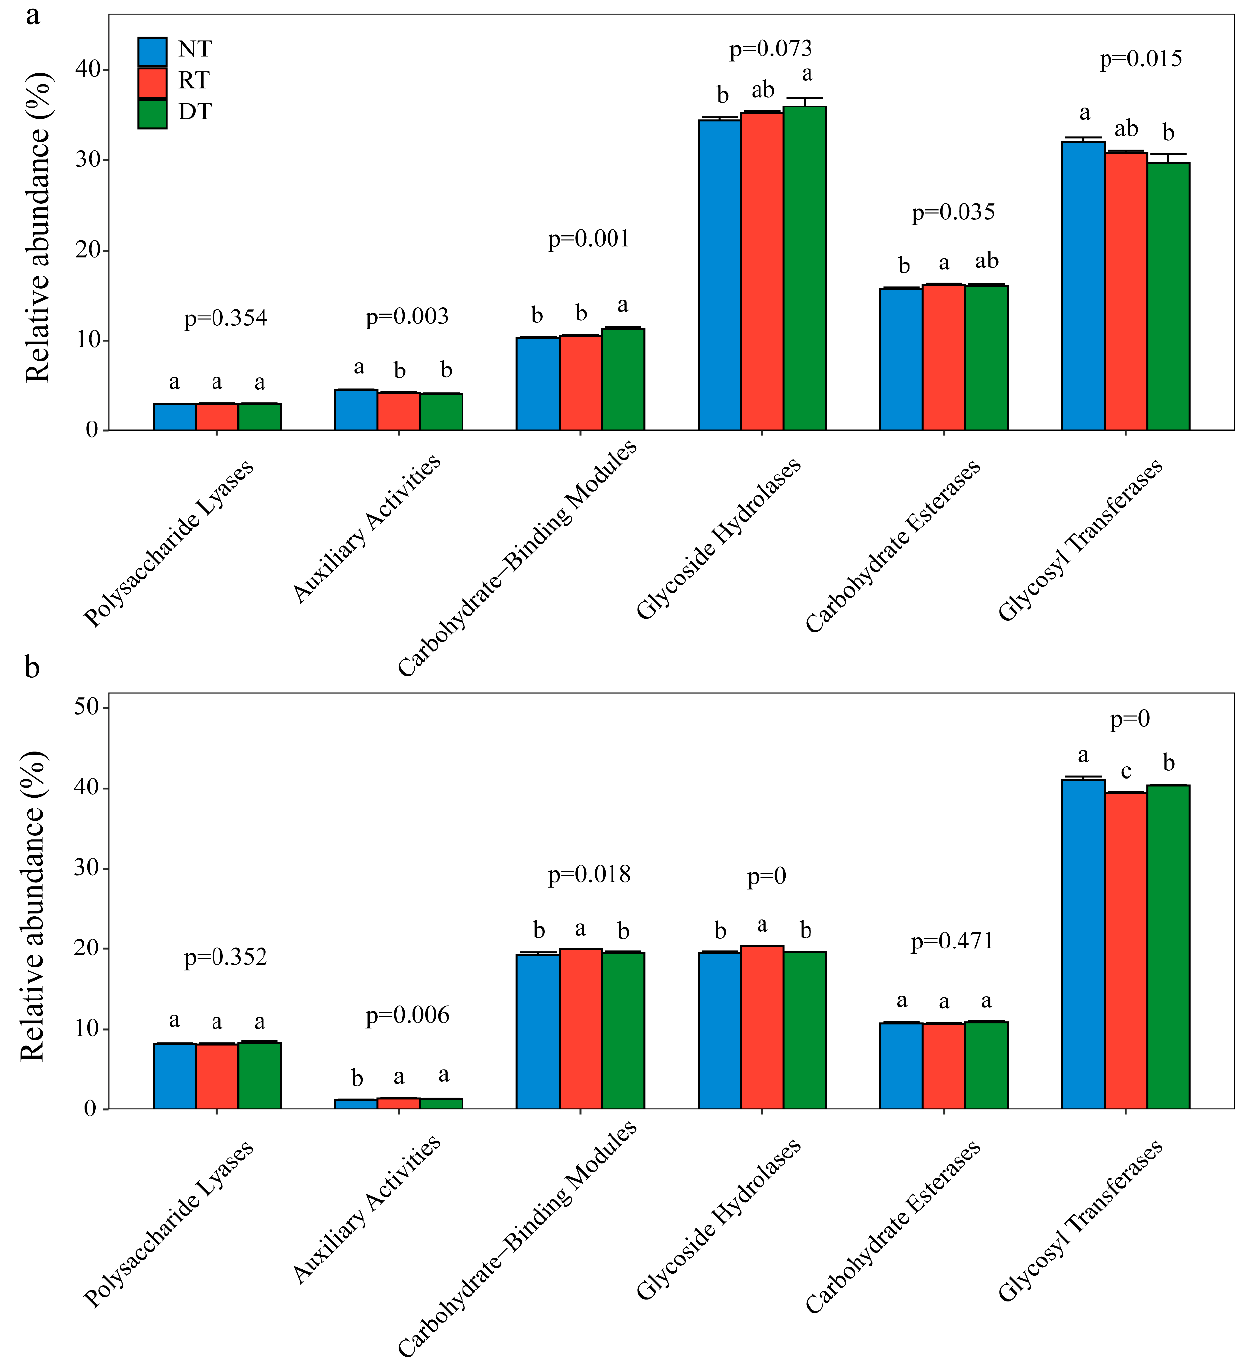
Figure 7. The variation of carbohydrate-active enzymes (CAZy) Database gene class profiles under different tillage methods. Values are the means ± standard deviation ( n = 3). ( a ) represents the wheat season, and ( b ) represents the maize season. Different letters in the figures indicate significant differences tested by Duncan’s multiple comparison.